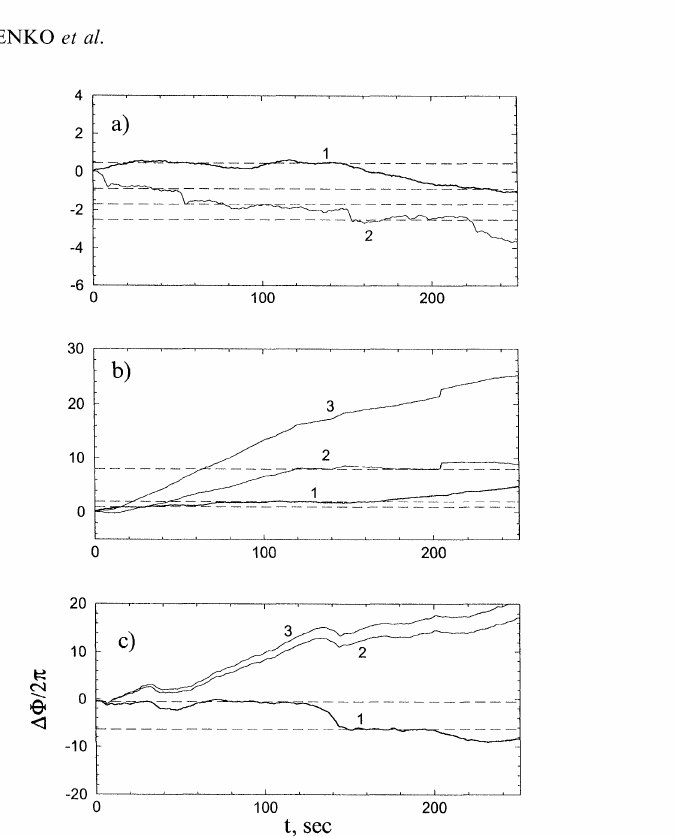
FIGURE 2 Instantaneous phase difference versus time. (a) Periodic forcing without frequency detuning; (b) periodic forcing with 3% frequency detuning; (c) irregular forcing gov- erned by the RR intervals of another individual. and ECG of a patient without forcing for